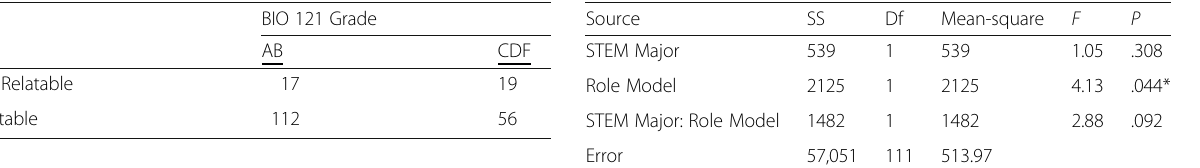
Table 3 Two-Way ANOVA testing peer leader role model status and student major on student perceived learning